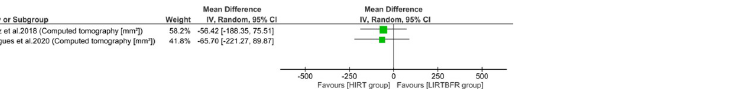
Fig 4. Forest plot of the comparison between LIRTBFR and HIRT on muscle mass (n = 2 studies). LIRTBFR: Low intensity resistance training combined with blood flow restriction; HIRT: High intensity resistance training; mm 2 : square millimeter; I 2 : Heterogeneity of studies; SD: standard deviation; MD: mean difference; 95% CI: 95% confidence interval; IV: inverse variance; Random: random effects model.